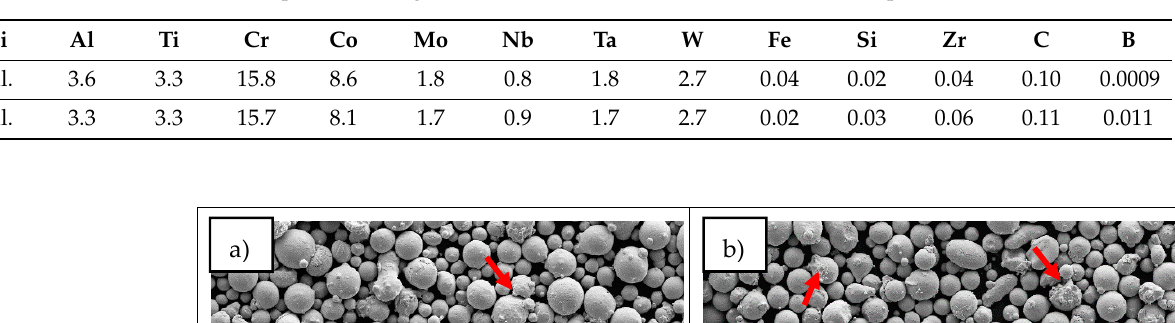
Table 1. Chemical composition (weight %) of Aubert and Duval and LPW IN738LC powders. Ni